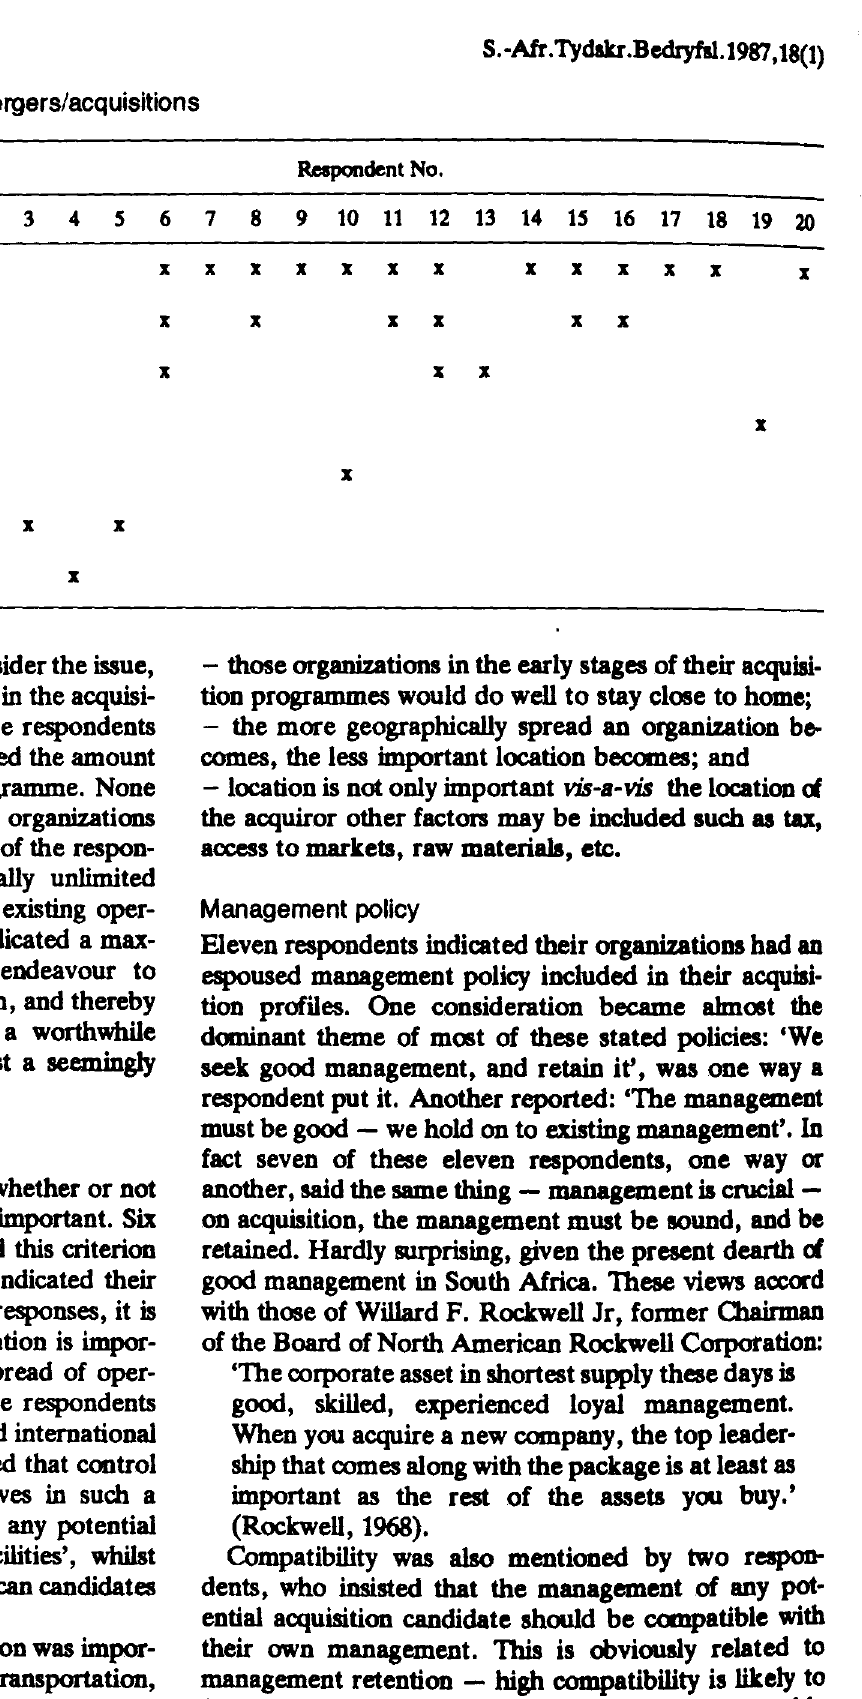
Table 3 General classification of past